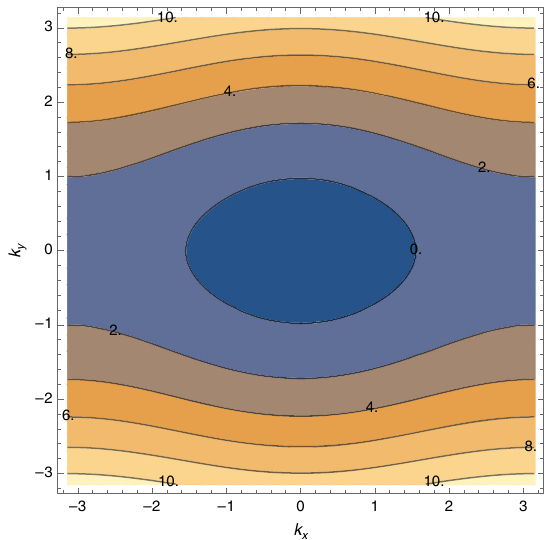
FIG. 6. Contour plots of the Pfaffian, Eq. (3.35), t ¼ 0 . 4 , t 0 ¼ 0 . 5 , ˜ t ¼ 0 . 4 , showing the FS for Pf ½ ˜ H ð k Þ(cid:3) ¼ 0 , which separatesthe regionwhere the Pfaffian changessign. For parameter values such that κ ¼ nQ , which correspond to t 0 ¼ 0 and t ¼ ˜ t , the FS shrinks to a doubly degenerate Dirac point at ð k x ; k y Þ ¼ ð 0 ; 0 Þ . We note, however, that this Dirac point is accidental, in the sense that it is a property of the continuum approximation of the band structure in which the original FS (in the absence of a PDW order parameter) is circular. Our numerical calculation indeed shows that this Dirac point is gapped once lattice effects become non-